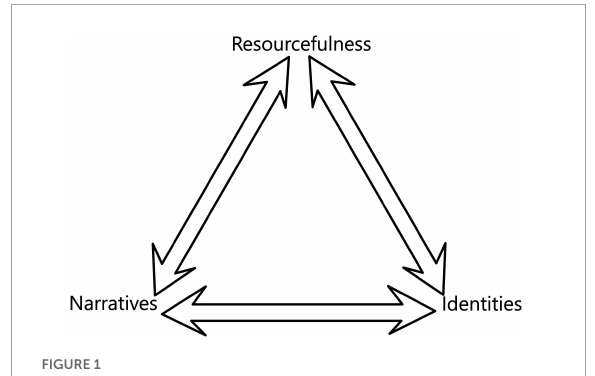
FIGURE1 Elements of rural Colombian maker